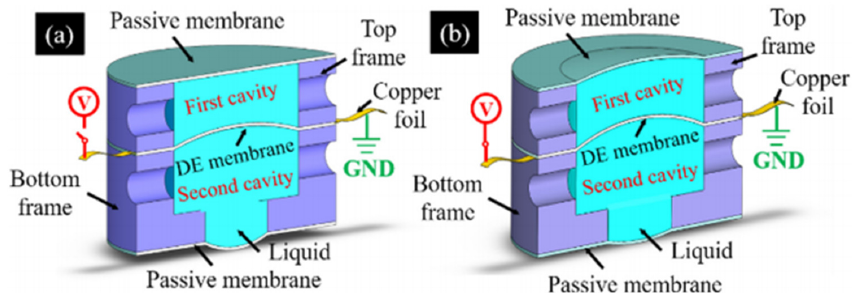
Figure 27. Dual-chamber sandwich DE lens: ( a ) In the initial state, the three membranes deform due to the hydraulic pressure. ( b ) Three membranes reshaped when a driving voltage is applied to the copper foil [116]. Reprinted with permission from Ref. [116]. 2020 The Optical Society.